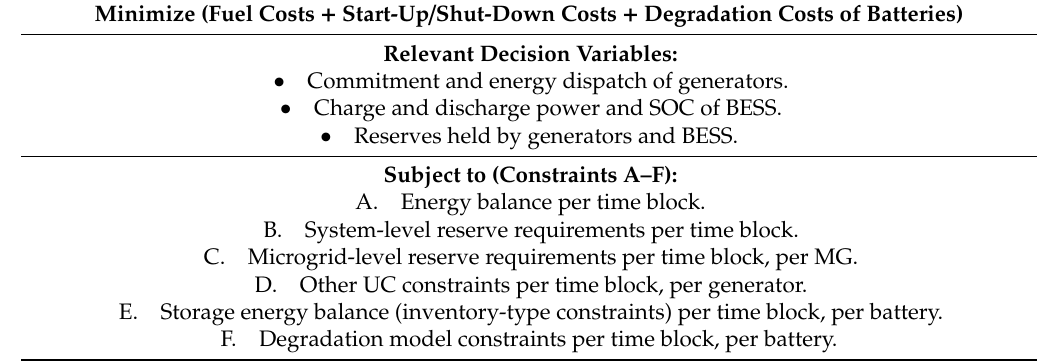
Table 1. Structure of the operation unit commitment (UC)